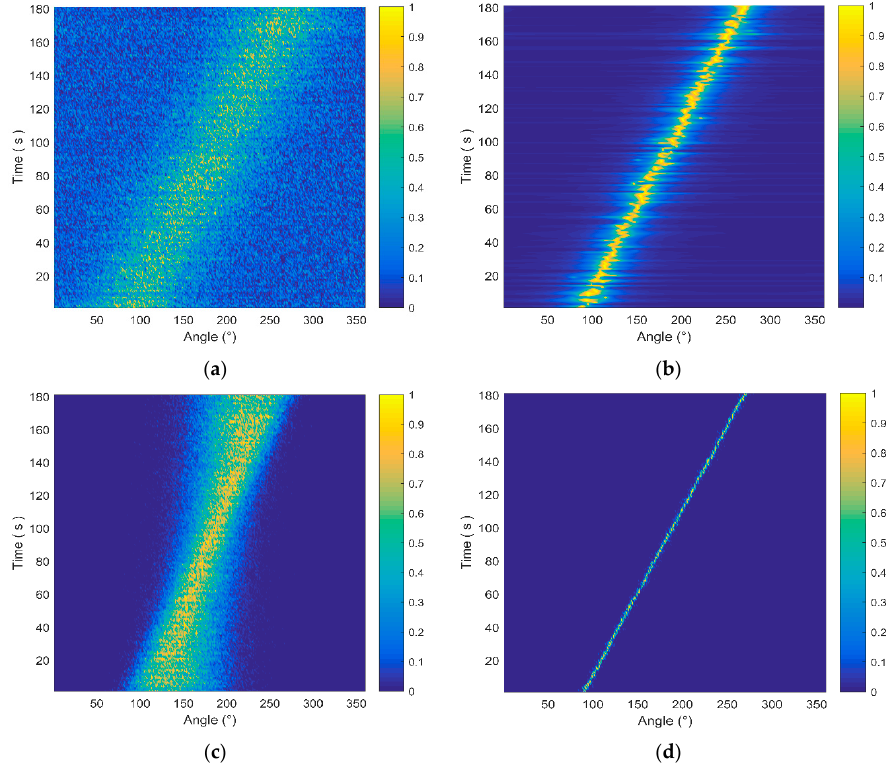
Figure 7. The estimation azimuth results of four methods with the processing frequency band of 100–1000 Hz. ( a ) Cross-spectral sound intensity method of single vector hydrophone (CSSI-SVH); ( b ) MUSIC method of single vector hydrophone (M-SVH); ( c ) data fusion algorithm for the vector hydrophone vertical array based on the cross-spectral sound intensity method (DF-CSSI); ( d ) the DF-WHS algorithm.